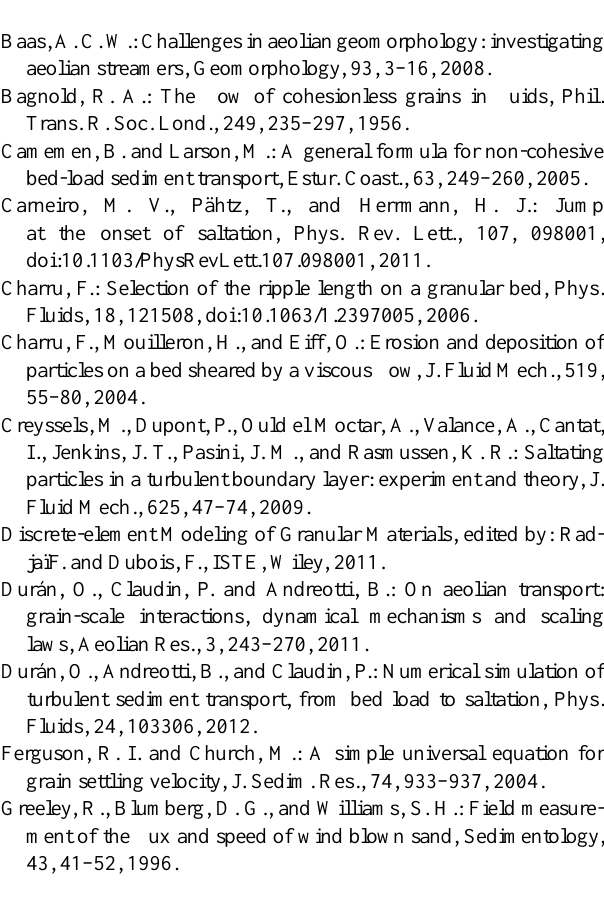
Fig. 6. Rescaled flow velocity u and grain velocity u p (inset) ver- tical profiles for different Shield numbers from simulations [empty ◦ symbols: 2 = 0 . 25 ( (cid:3) ), 0 . 36 ( ) and 0 . 5 ( 4 )] and measurements from Mouilleron et al. (2009) [filled symbols: 2 = 0 . 26 ( (cid:4) ), 0 . 39 • N ( ) and 0 . 52 ( )]. Note: to facilitate the comparison the reference elevation z = 0 is redefined following Mouilleron et al.